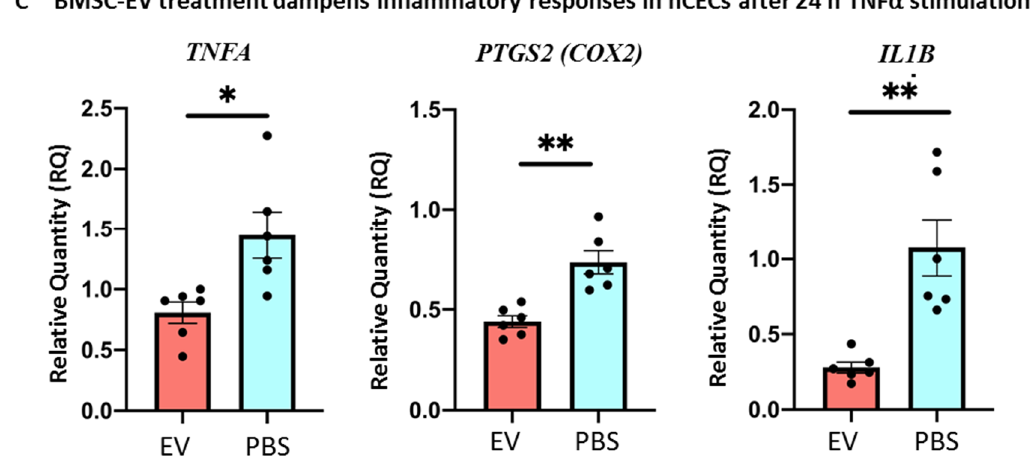
Figure 8. Effects of BMSC-EV treatment on primary human corneal epithelial cells (HCECs) in vitro. ( A ) Representative images of the wound-healing assay. Wound closure dynamics of HCECs after treatment with BMSC-EVs or PBS at different timepoints are shown. The white dashed lines are the edges of the cell migration at 0 h. Scale bar = 50 µ m. The graph shows quantification of wound repair. Data represent mean ±SD; n = 5, ** p < 0.01. ● represents biological replicates ( B ) HCECs were treated with a single dose of 5000 PKH26-labelled EVs/cell. EV internalization in HCECs 24 h after treatment is shown (red signal). Insert shows larger magnification of selected area. Scale bar = 50 µm. ( C ) qRT-PCR analysis of inflammation-related gene expression in HCECs treated with TNF α for 4 h, followed by treatment with a single dose of EVs at 5000 EVs/cell or PBS for 24 h. Data show mean ±SD; n = 6; * p < 0.05, ** p < 0.01. ● represents biological replicates